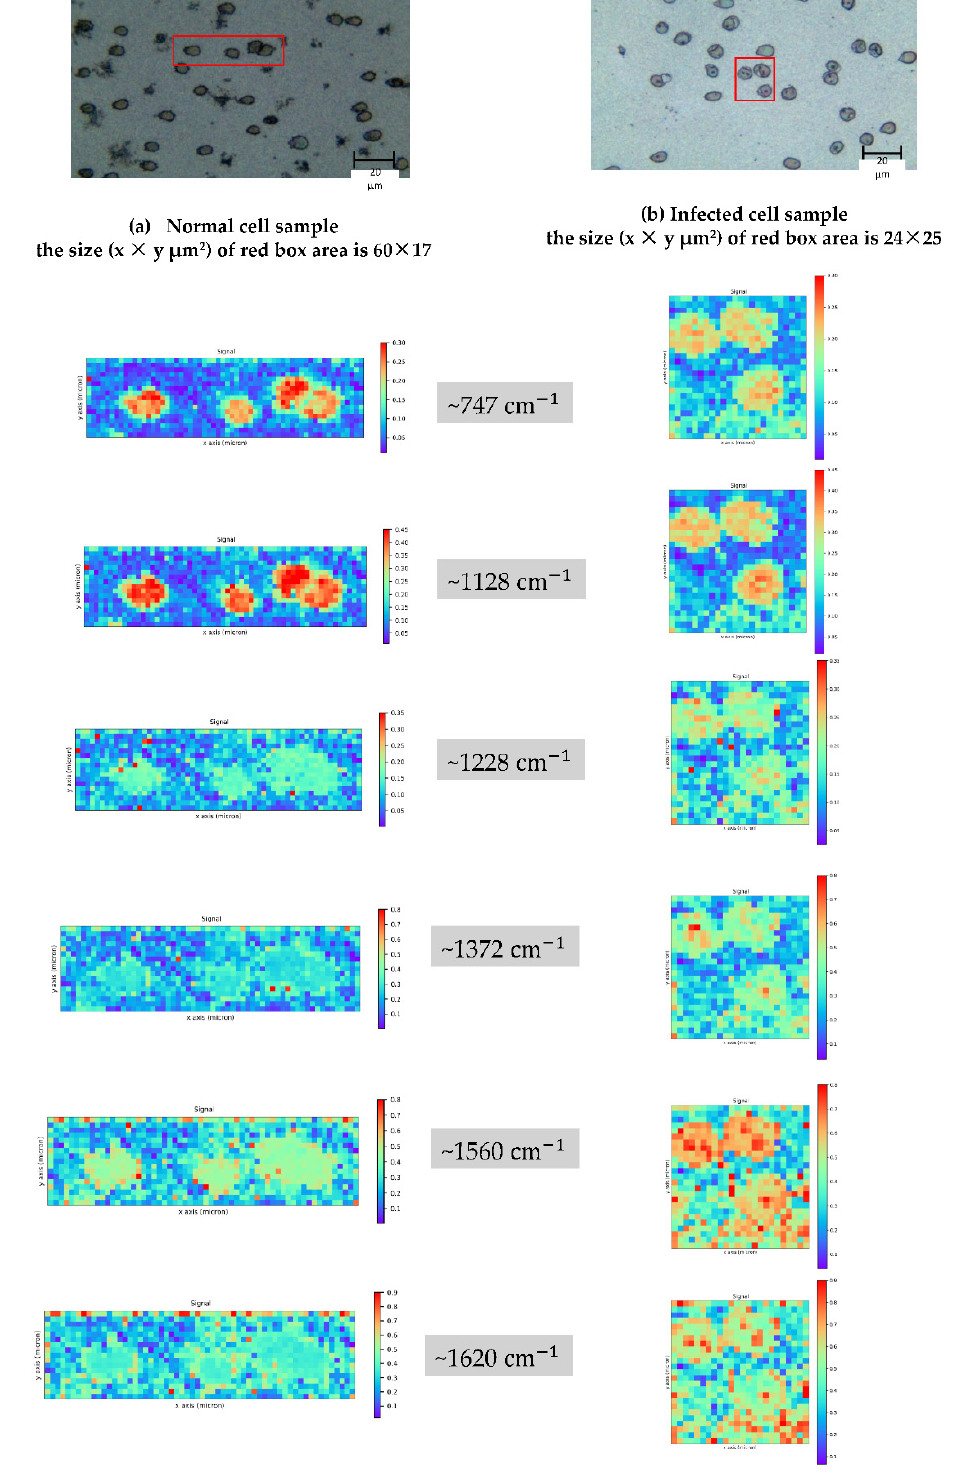
Figure 2. Image shows white light images of normal ( a ) and infected red blood cells. ( b ) The red boxes indicate the mapped area with the normalized intensities covering the peaks at 747, 1128, 1228, 1372, 1560 and 1620 cm − 1 . These maps visually compare the healthy red blood cells and the P. falciparum (3D7) infected red blood cells. The increase or decrease in the intensity of the Raman spectrum can be linked with the biological component’s modification in the red blood cell. The information regarding peak assignment is shown in Table 1.